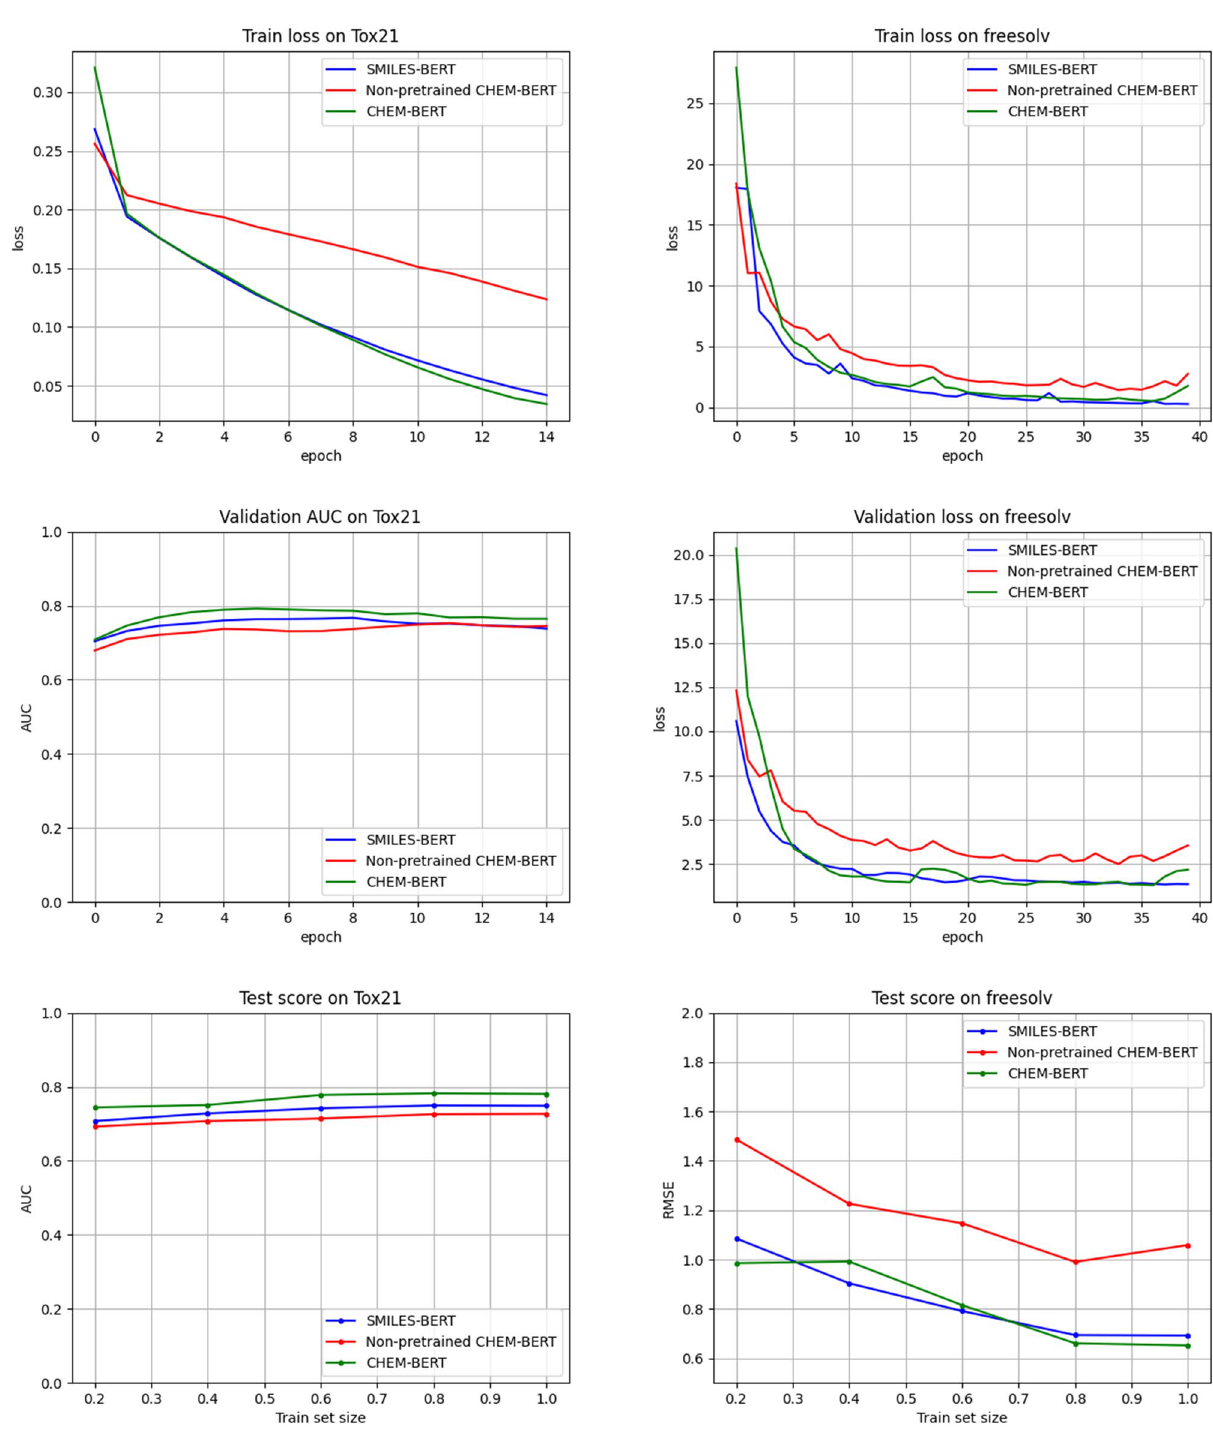
Figure 3. Train, validation, and test curves of Tox21 (classification) and Freesolv (regression). Pre-trained models converge faster than a non-pretrained model shown in train and validation curves. Test curves show model performance against different train sizes. CHEM-BERT performs better than others at almost all training